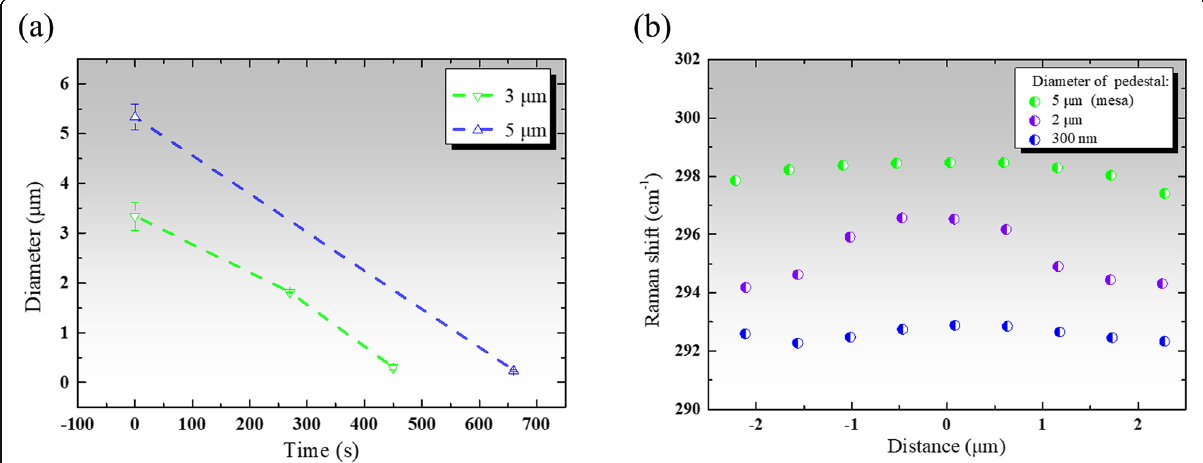
Fig. 5 a The diameter of the Ge pedestal as a function of selective wet etching time for 3 μ m (green dashed line) and 5 μ m (blue dashed line) diameters Ge 0.902 Sn 0.098 disks. b Raman shift line scan measurements performed along the diameter of 5 μ m Ge 0.902 Sn 0.098 mesa (green dot) and microdisks with 2 μ m diameter Ge pedestal (purple dot) and 300 nm diameter Ge pedestal (blue